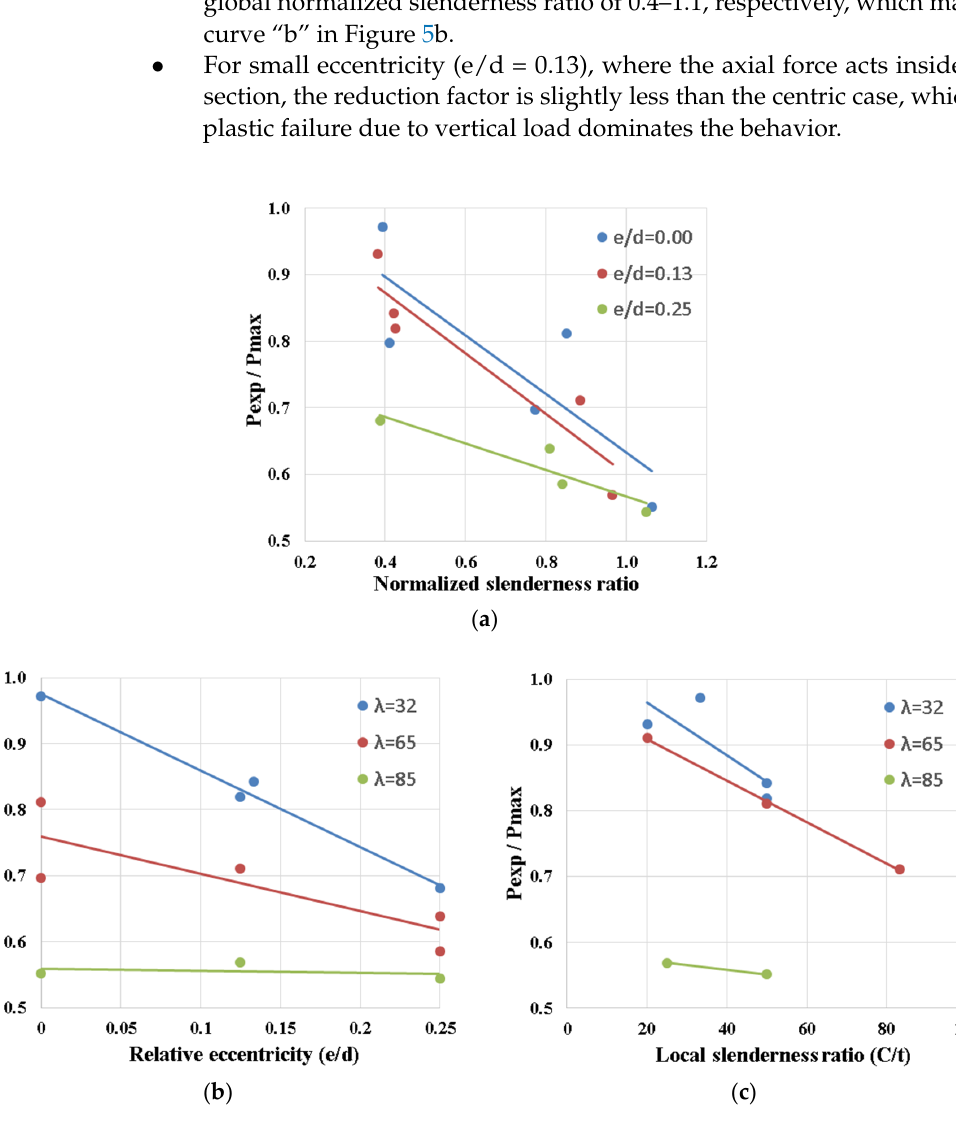
Figure 8. Relation between (P exp /P max ) and ( a ) normalized slenderness ratio, ( b ) relative eccentricity and ( c ) local slenderness ratio. and ( c ) local slenderness